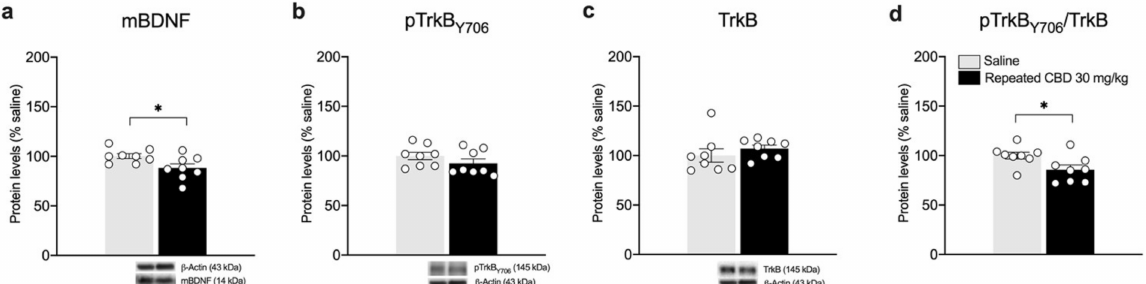
Figure 7. Effects of repeated CBD exposure on mBDNF and TrkB receptor protein levels in the mPFC. Rats were treated with repeated injections of 30 mg/kg for seven days and killed twenty-four hours after the last treatment. Protein levels of BDNF ( a ), phospho(p)-TrkBY706 ( b ), TrkB ( c ), and of the ratio pTrkB/TrkB ( d ) measured in the homogenate of mPFC are expressed as percentages of saline-treated rats. Below the graphs, representative immunoblots are shown for mBDNF (14 kDa), pTrkBY706 (145 kDa), TrkB (145 kDa), and β -Actin (43 kDa) proteins. Bar graphs represent the mean ± SEM from eight independent determinations for each experimental group. Unpaired Student’s t -test or Wilcoxon − Mann − Whitney test. * p < 0.05 vs. saline-treated rats. Saline n = 8, CBD 30 mg/kg n =